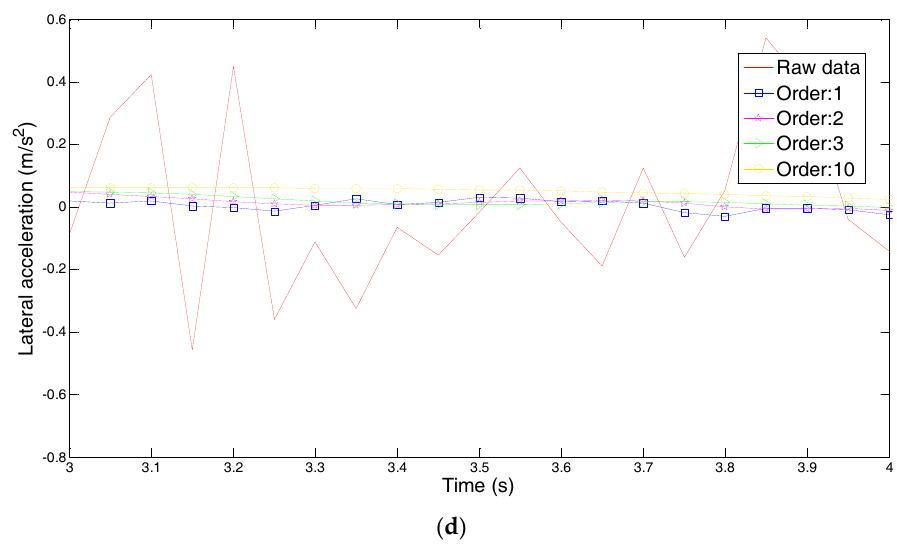
Figure 3. Filter results with the Butterworth filter: ( a ) torque; ( b ) angular velocity; ( c ) yaw rate; and ( d ) lateral acceleration.